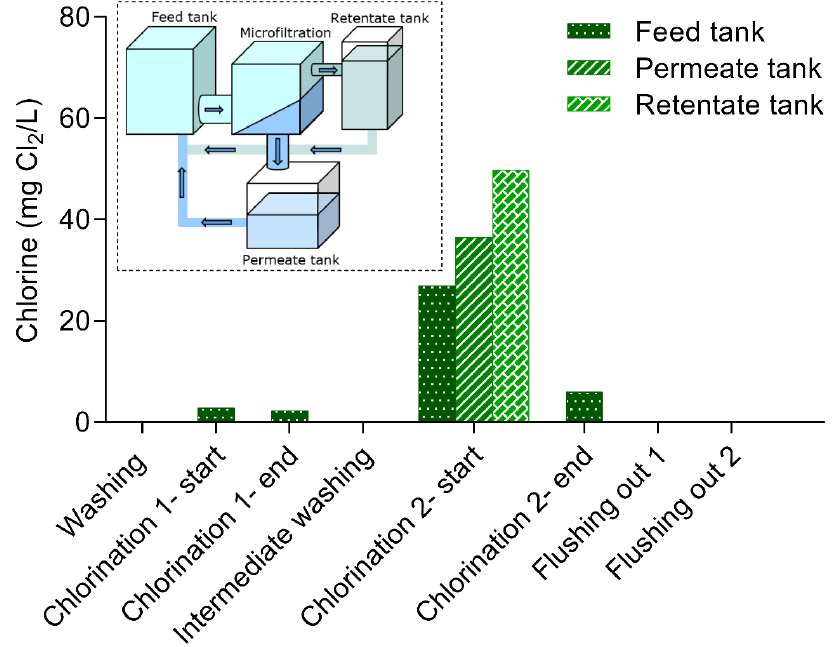
Figure 6. Concentration of free chlorine in samples acquired from the cleaning process in the food industry. Insert (stipple box): Schematic of a membrane system and flow during recycling of water in the cleaning process.